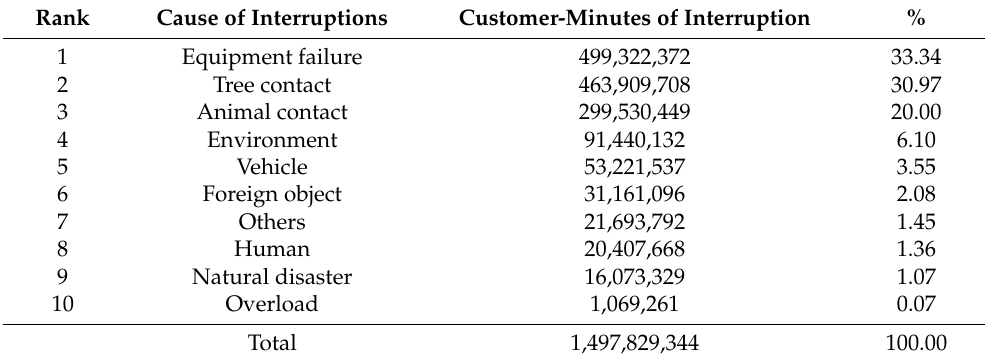
Table 1. Causes of power interruptions and customer-minutes of